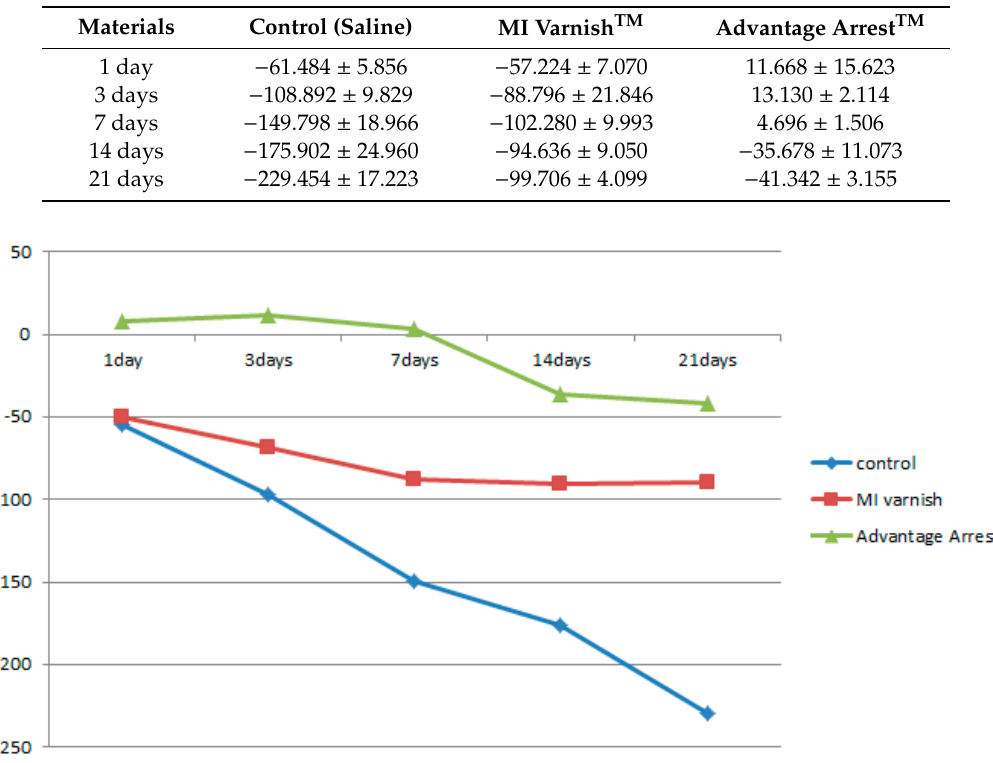
Figure 6. Comparison of the change in mean enamel Hounsfield unit value at a depth of 0–20 µ m between groups at each time point.